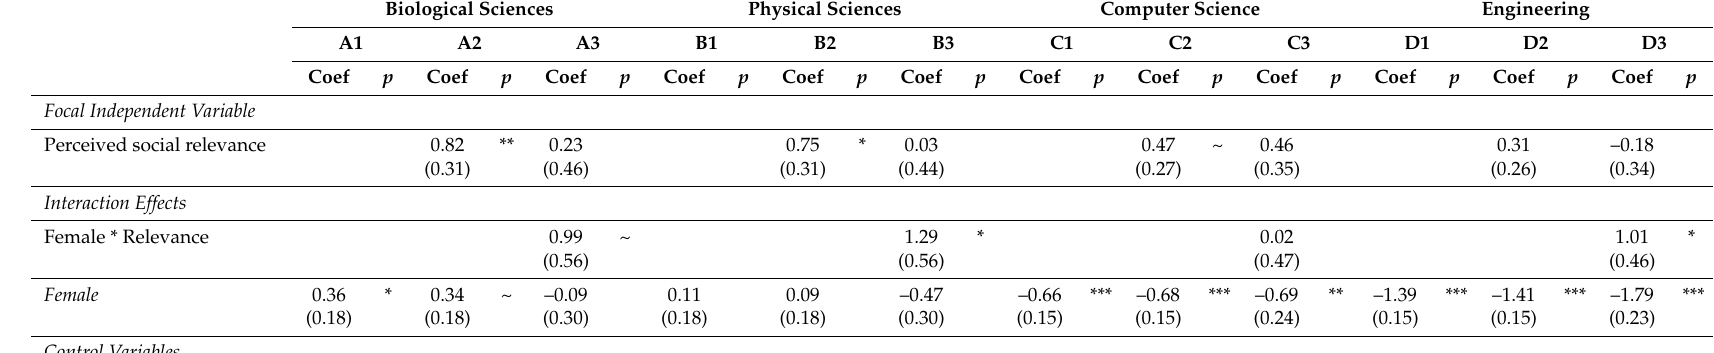
Table 3. Results from Logistic Regression Models Predicting Expectations to Major in Specific STEM Fields (Coefficients with standard errors in parentheses) (N =